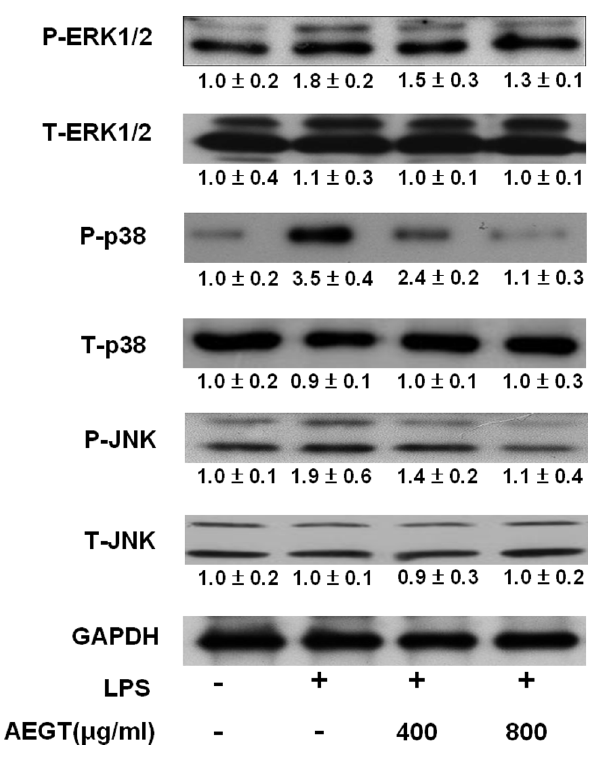
Figure 5. Effect of AEGT on MAP kinase phosphorylation in LPS-stimulated RAW 264.7 cells. The RAW264.7 cells were seeded in a 24-well plate, treated with 400 or 800 m g/ml AEGT for 1 h and stimulated with 1 m g/ml LPS for 24 h. The cell lysates were collected, and p38, JNK, and ERK1/2 phosphorylation was analyzed by western blot analysis with specific antibodies. The relative value of the LPS- group or AEGT/LPS-treated group over the untreated group was measured by densitometry following normalization to cellular GAPDH levels. The basal level of promoter activity in the AEGT/LPS-untreated cells was defined as 1. Error bars indicate the means 6 SD of three independent experiments. * P , 0.05; ** P , 0.01.